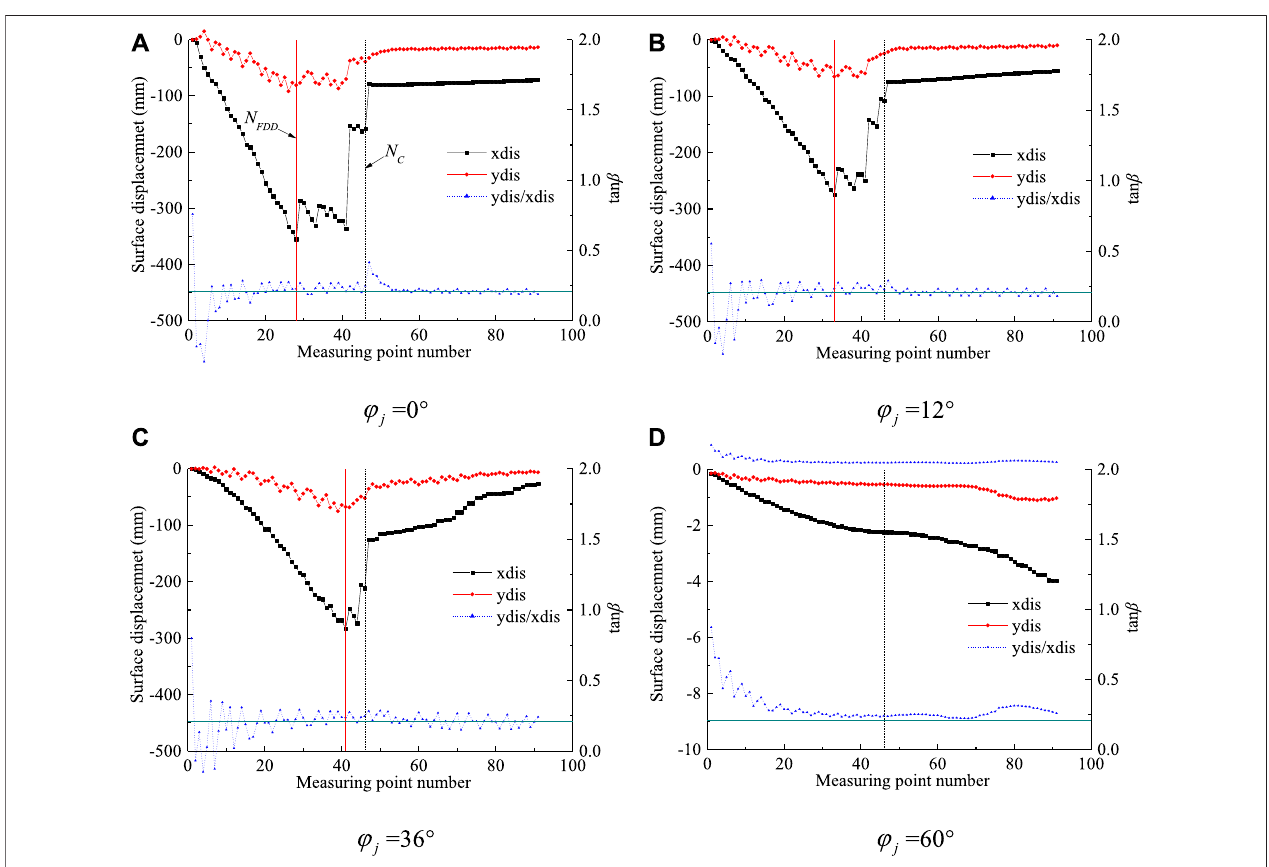
FIGURE9| Surfacedisplacementdistributionofslopefordifferentjointfrictionangles( φ j ). N C and N FDD :Measuringpointscorrespondingtotheslopecrestand fi rst displacement discontinuity, respectively.